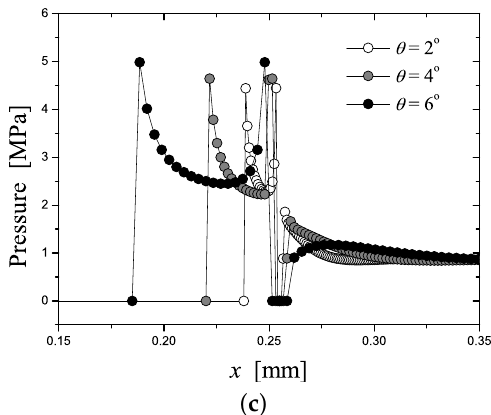
Figure 3. Simulation results of profiles of contact pressure between the two substrates: ( a ) Interference width is varied, while interference height ( h 2 ) and draft angle ( θ ) are fixed as 500 µ m and 4 ◦ ; ( b ) Interference height is varied, while interferenc width and draft angle are fixed as 10 µ m and 4 ◦ , respectively; ( c ) Draft angle is varied, while interference width and height are fixed as 10 µ m and 500 µ m, respectively. Applied pressure is 1 MPa.